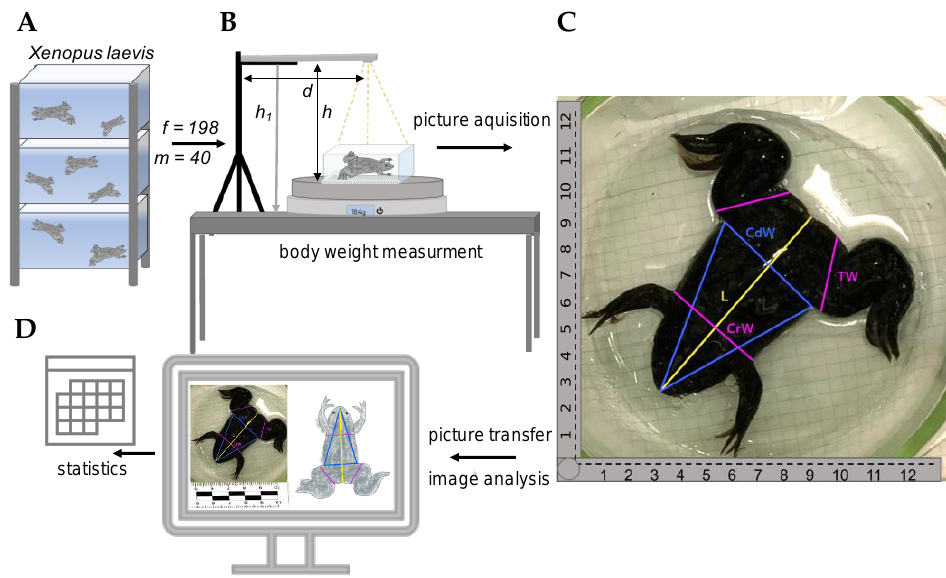
Figure 1. ( A ) Xenopus laevis frogs were housed in groups of 10–15 animals. In total 198 males (m) and 40 females (f) were used to establish the method. ( B ) Camera set-up. The tablet was mounted on the tripod at a fixed distance ( d ) and height of 49 cm ( h 1 ) above the table, resulting in a 44 cm distance between the tablet and the ground of the basin ( h ), where the frogs were placed. Body weight was measured for each frog in parallel to the image acquisition. ( C ) Lines showing all the measurements that were taken from each frog (cranial width CrW, caudal width CdW, snout–vent length L, thigh width TW). The metric scale was used for the calculation of actual distances from the photograph. ( D ) GIMP© image analysis software was used to measure distances drawn on the frogs’ dorsal planes.